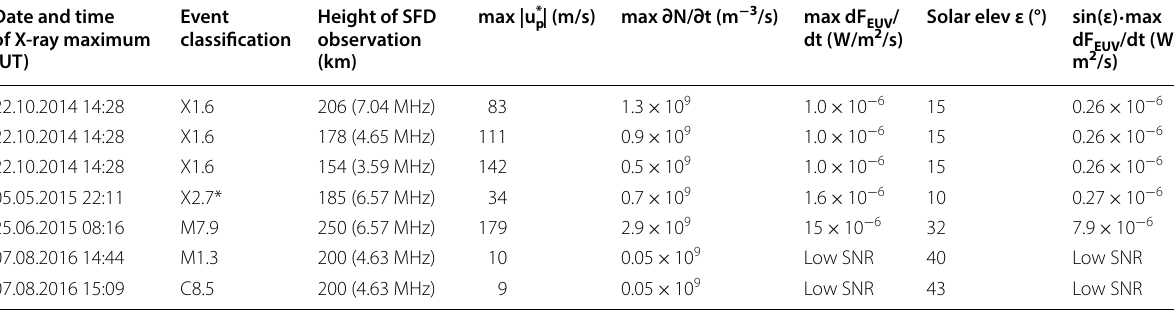
* The observation of X2.7 by CDSS on 5 May 2015 was presented in the paper by Laštovička and Chum (2017)